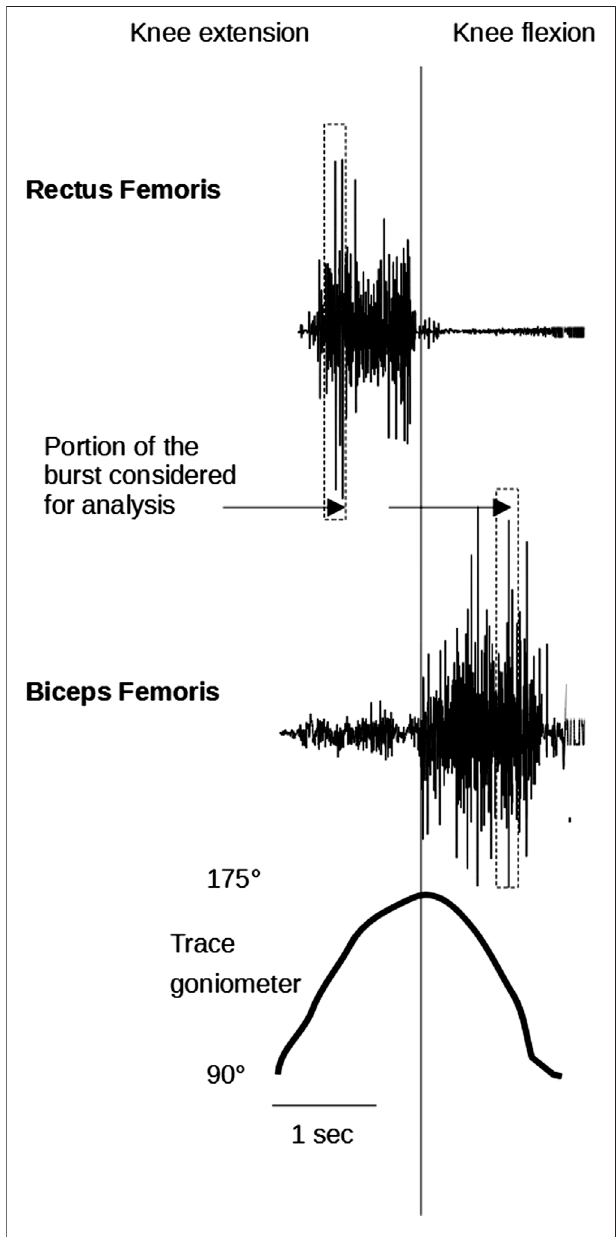
FIGURE2| The fi guredepictsarawsurfacemyoelectricsignalrecorded during two repetitions of extension/ fl exion of the knee during the fatigue test withisokineticdevice.Thevertical rectangularbandsidentifytheportion ofthe burst considered for analysis of EMG spectrum in each cycle.